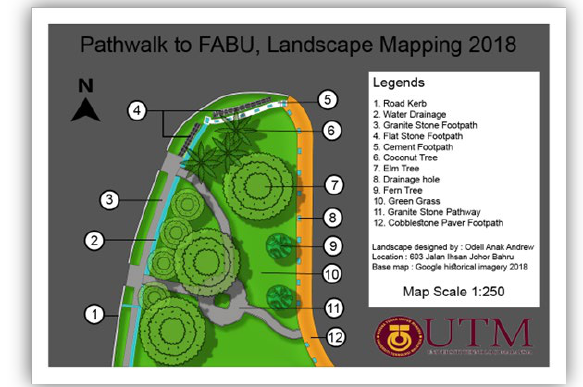
Figure 3.4 Pathwalk to FABU, Landscape Mapping 2018 produced based from the architecture conventional method via google based map